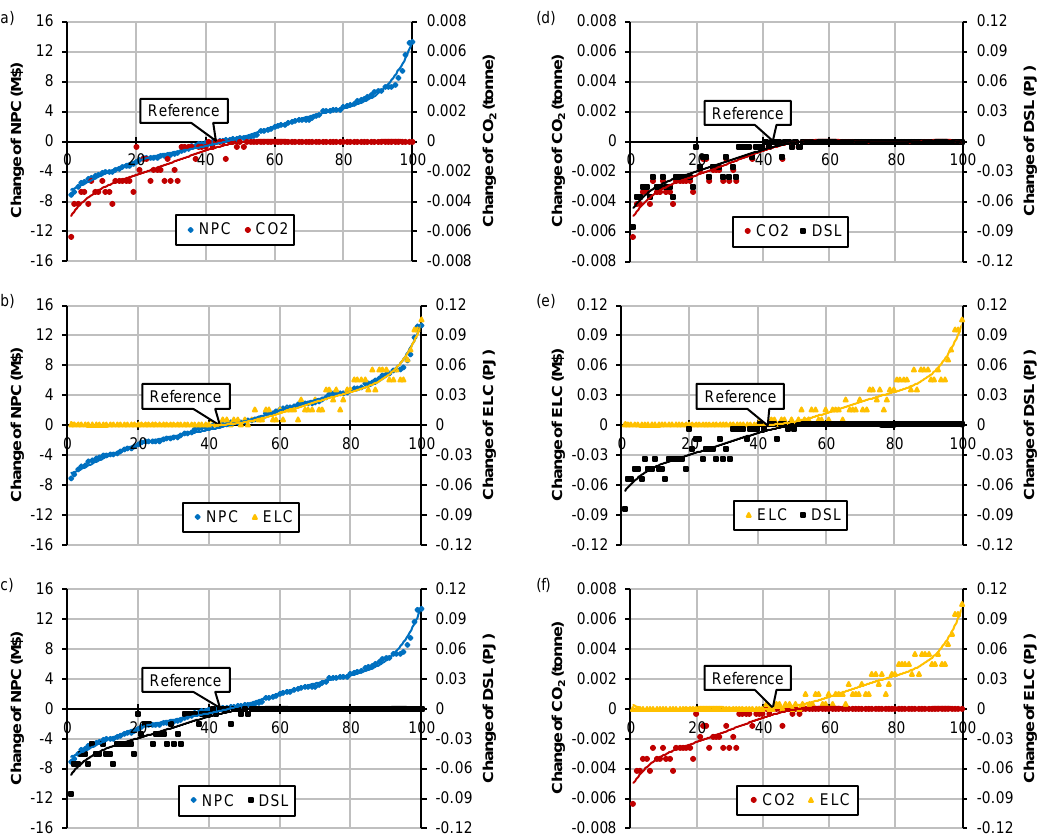
Figure 5. Cumulative distributions of absolute changes for net present cost (NPC), CO 2 emissions, electricity consumption (ELC), and diesel consumption (DSL) in UTOPIA’s energy system over the period 1990–2010. Data was obtained from the 100 simulations and reference case (horizontal axis: percentage of the cumulative distributions from 0% to 100%). ( a ) Changes of NPC and CO 2 versus NPC distribution; ( b ) Changes of NPC and ELC versus NPC distribution; ( c ) Changes of NPC and DSL versus NPC distribution; ( d ) Changes of CO 2 and DSL versus NPC distribution; ( e ) Changes of ELC and DSL versus NPC distribution; ( f ) Changes of CO 2 and ELC versus NPC distribution;